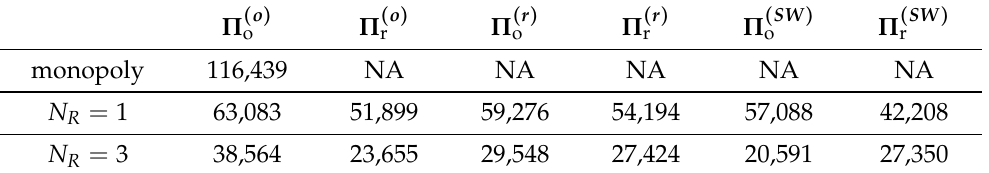
Table 2. Profits of operators under different